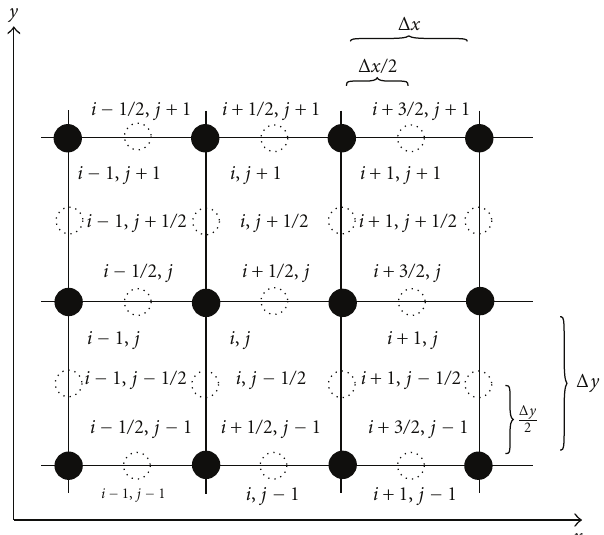
Figure 1: Staggered